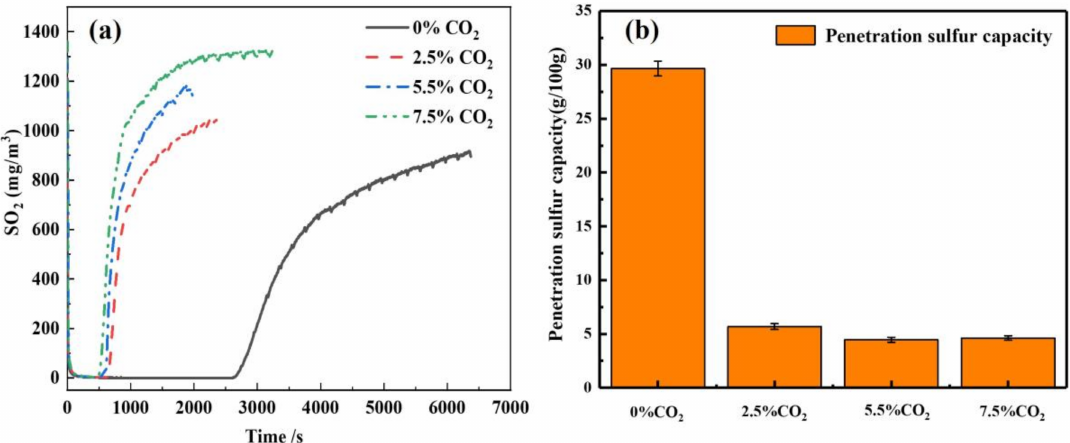
Figure 9. ( a ) Effect of different CO 2 contents on desulfurization time; ( b ) sulfur penetration capacity of adsorbents at 20% relative humidity.